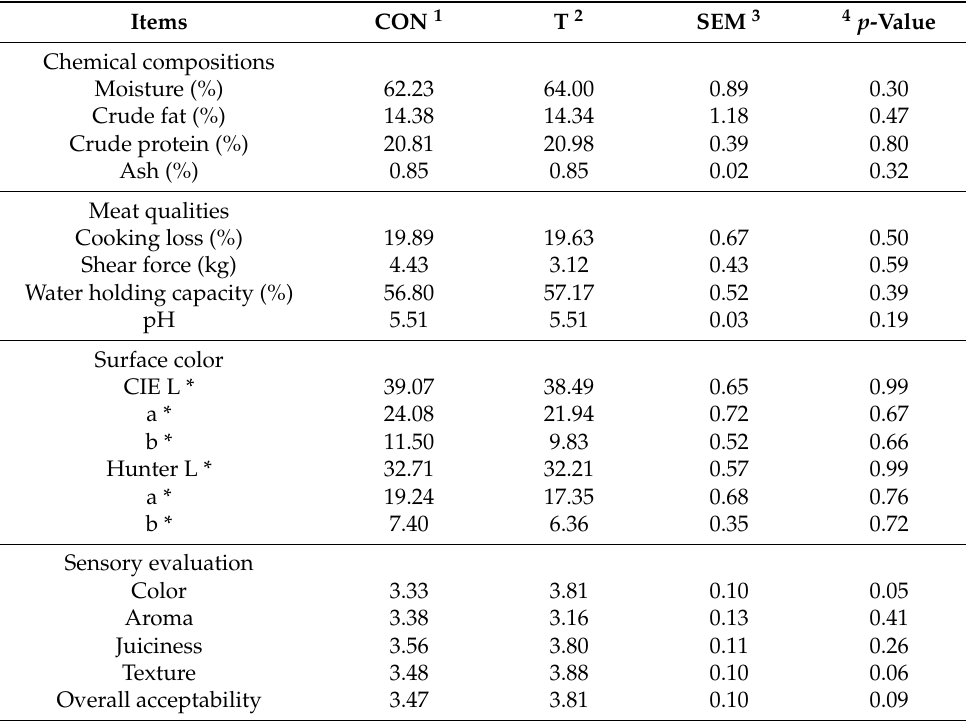
Table 5. Chemical compositions and meat quality characteristics of control or treatment